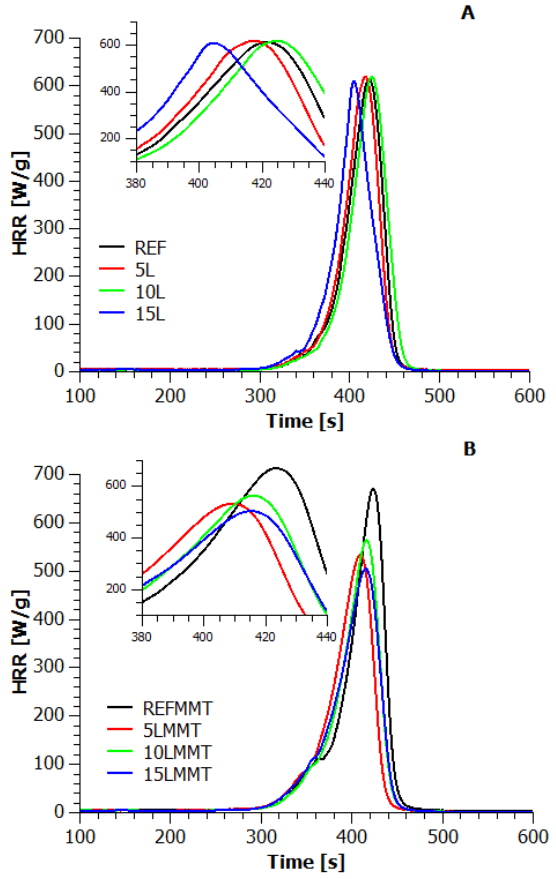
Figure 4. Heat release rate (HRR) as a function of time of the polymeric materials coated using the LbL method: ( A ) the samples without nanofiller; and ( B ) the samples with nanofiller. Table 5. Point of heat release rate (PHRR) parameters for the materials coated utilizing the LbL